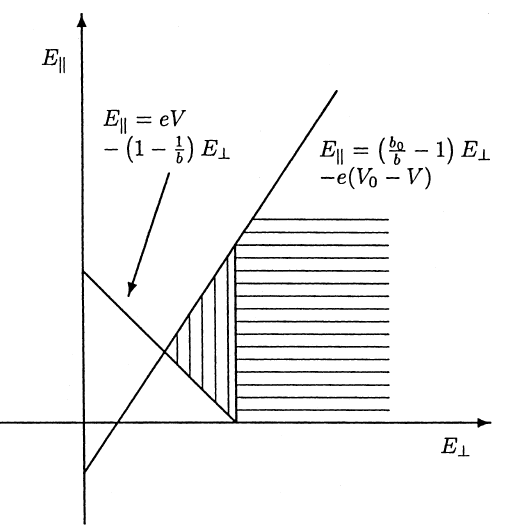
Fig. 2. The integration domain in Eq. (16). The vertical hatching corresponds to the first term and the horizontal hatching the second term. The domain is limited by two lines , the equations of which are shown, together with the E ? axis. As long as the FL-condition